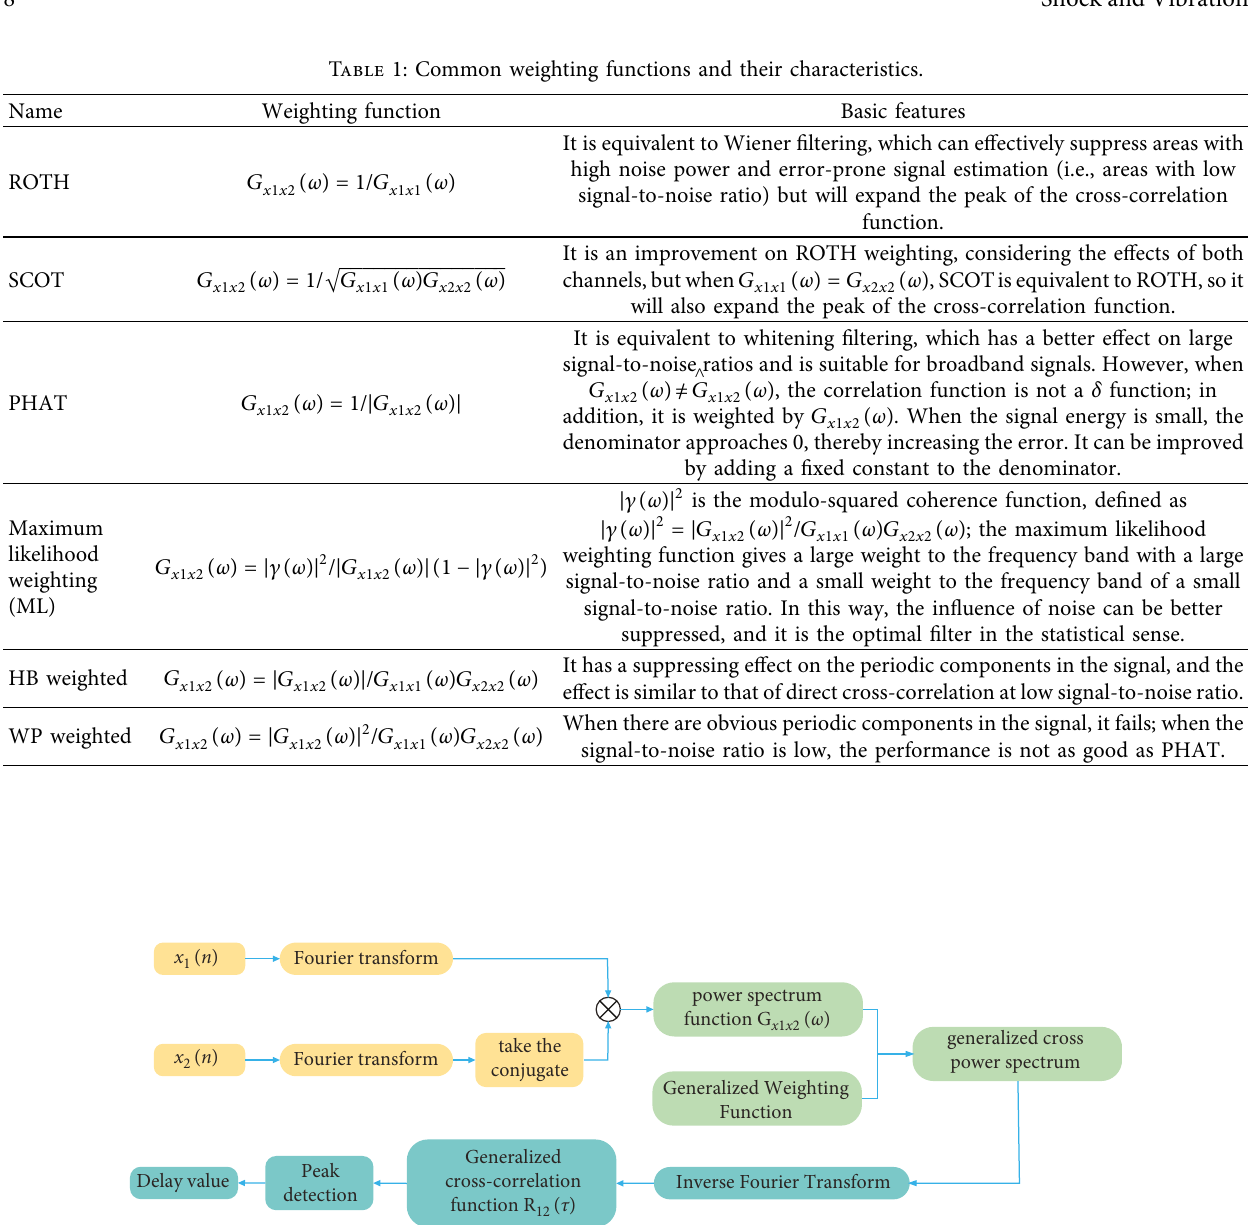
Table 1: Common weighting functions and their characteristics.